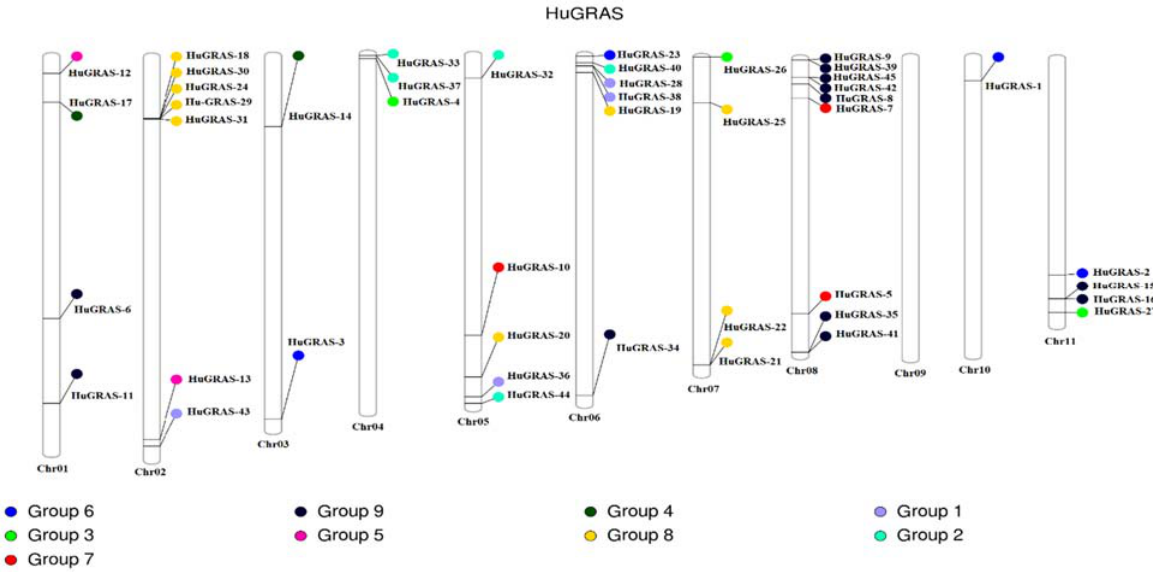
Figure 4. Distribution of 45 HuGRAS genes on 11 pitaya ( S. undatus L.) chromosomes. Gene names are mentioned in black. HuGRAS genes are divided into nine groups on the basis of their domain structures.